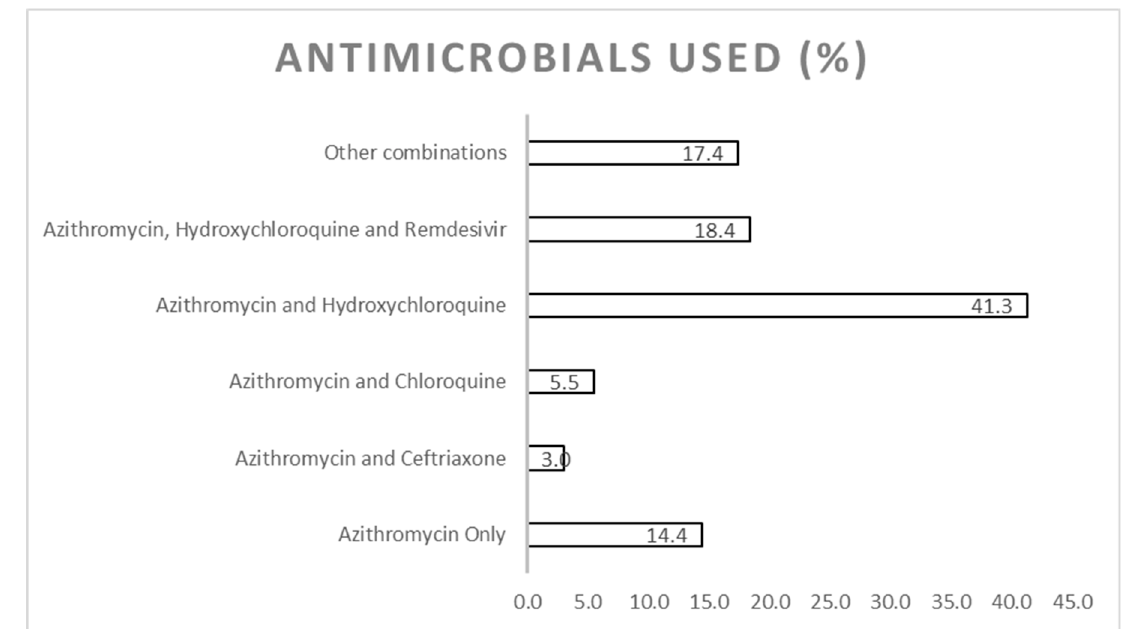
Figure 1. Antimicrobial agents prescribed for the management of COVID-19 infection among pedi- atric patients at the University of Ghana Medical Centre.